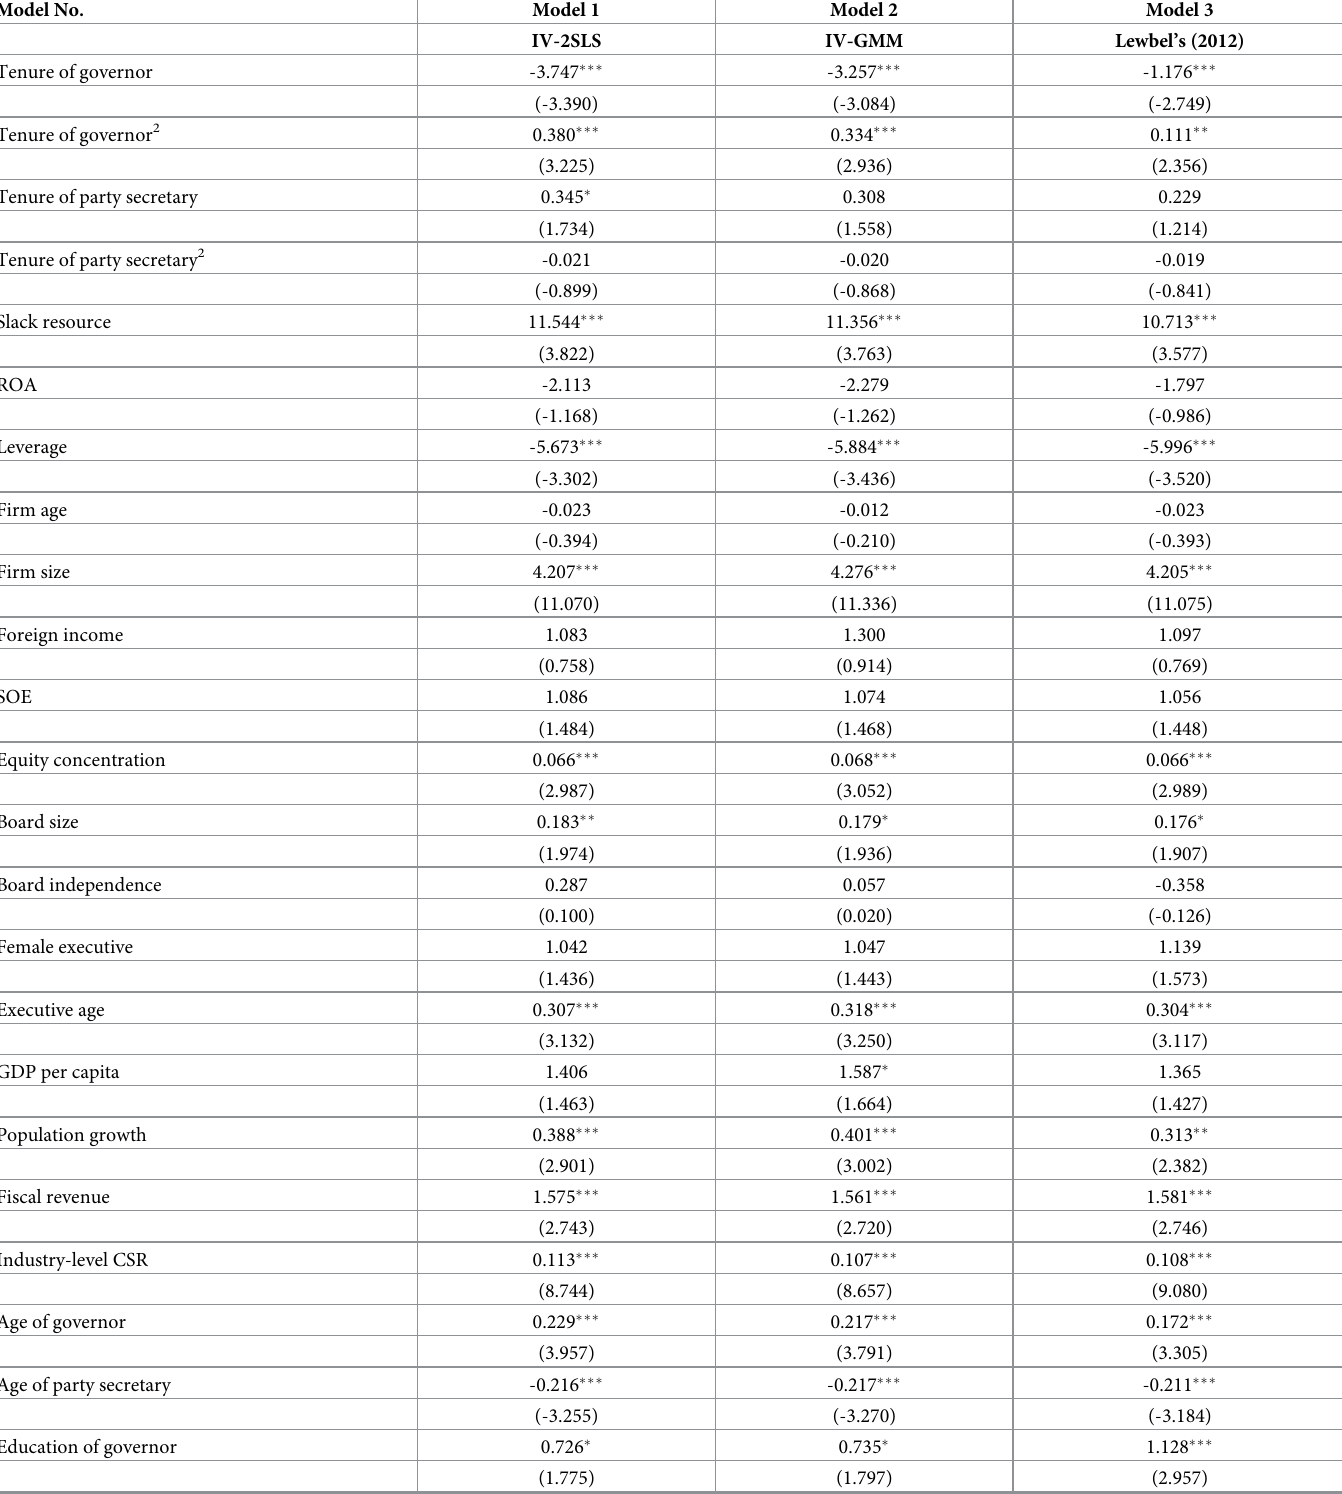
Table 5. Endogenous test